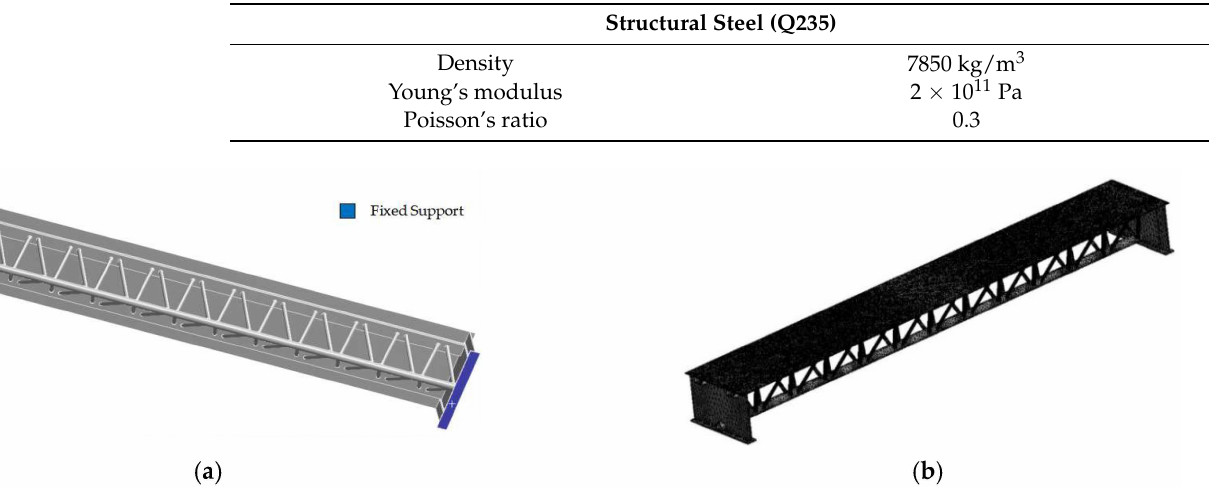
Table 2. Structural material parameters for the STTGB.